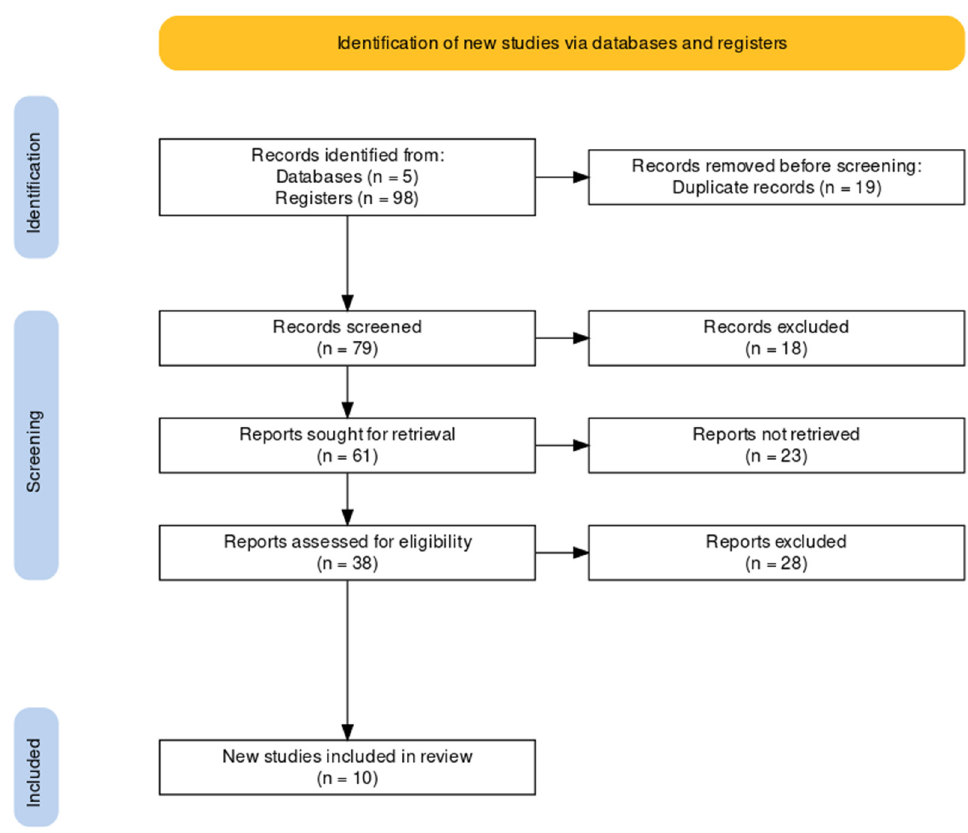
Figure 1. PRISMA flow diagram for systematic review of wrist wearables to identify stress.